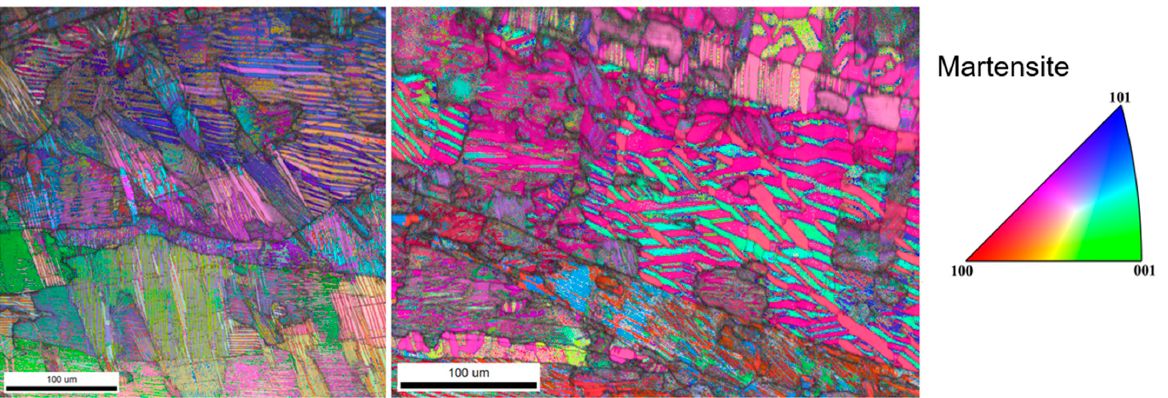
Figure 6. Electron backscatter diffraction (EBSD) images of as laser melted Ni-Mn-Ga powder.